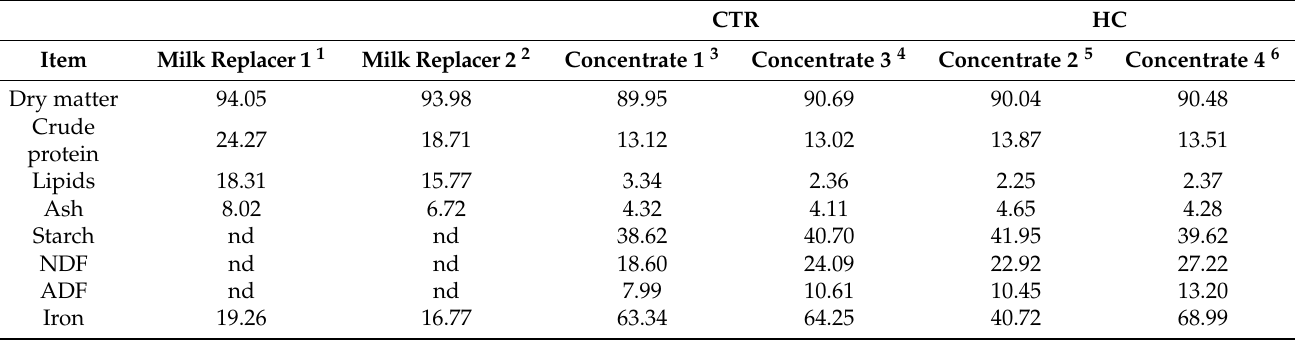
Table 2. Chemical composition (% on DM) and iron content (mg/kg) of milk replacers and concentrates.